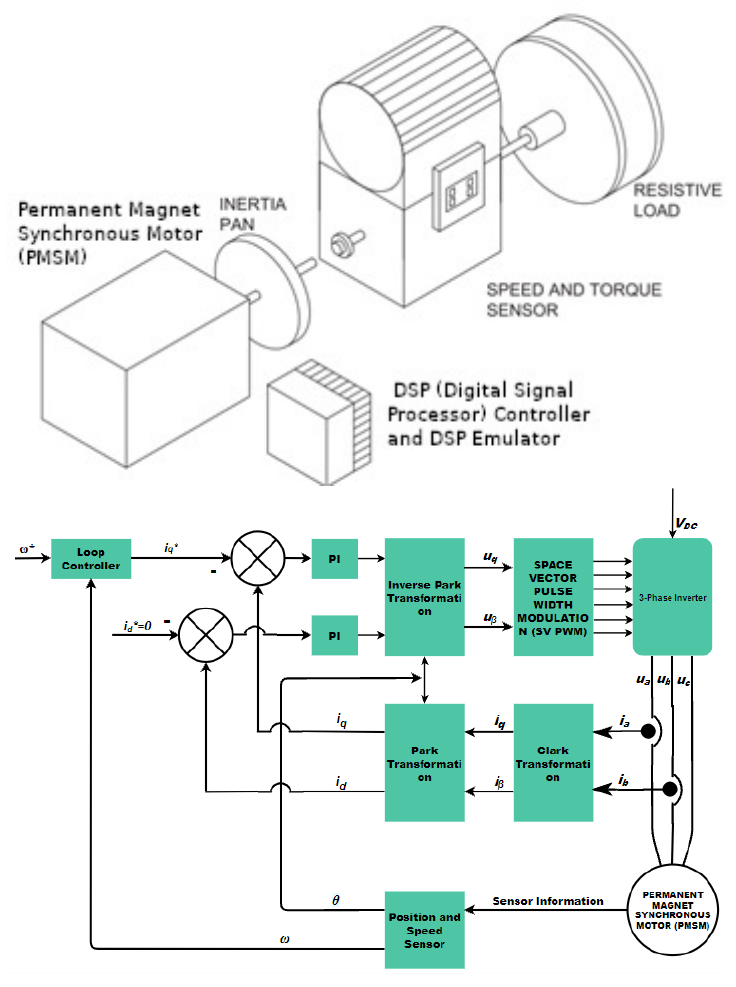
Figure 1. ( Above ) Permanent-magnet synchronous motor. ( Below ) Model block diagram. The system in (3) can be transformed [17] into a chain of integrators. To do so, let us introduce new state variables v 1 ( t ) = ˙ ω and v 2 ( t ) = ˙ v 1 . After calculating the derivatives of v 1 ( t ) and v 2 ( t ) in view of Equation (3), the following system in the chain of integrators form is obtained: